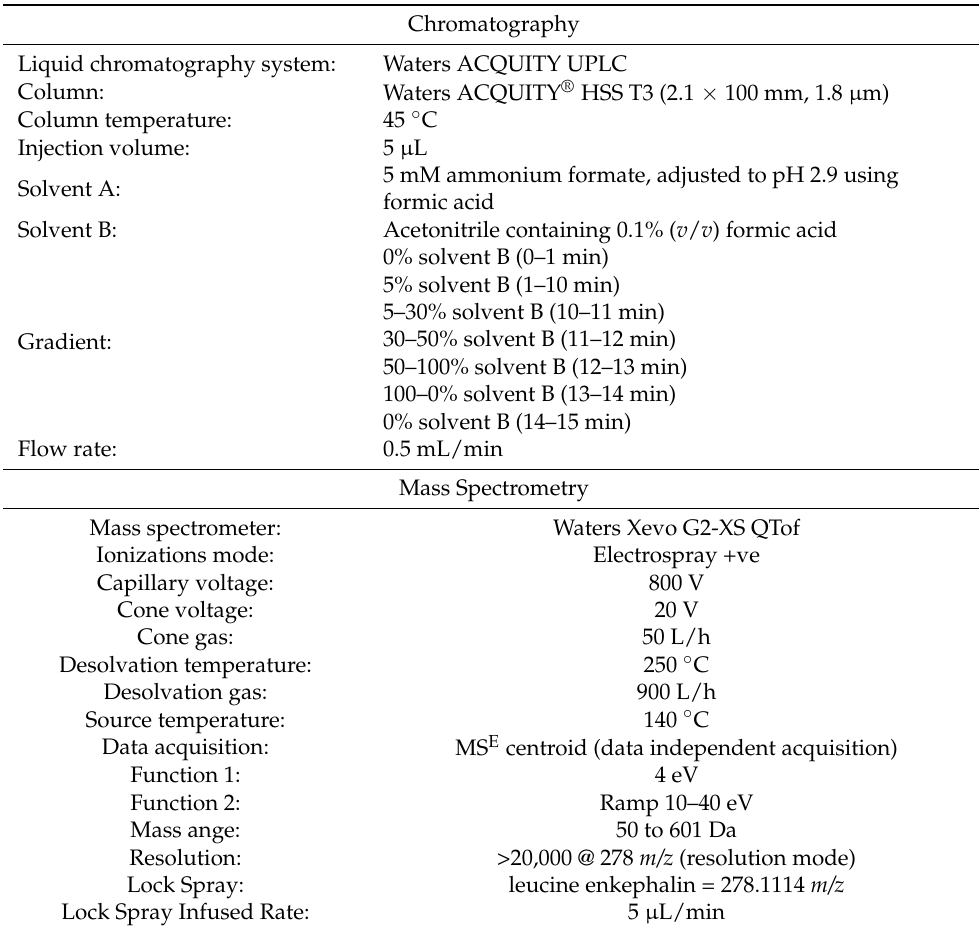
Table 2. Optimized UPLC-qTOF-MS method parameters.